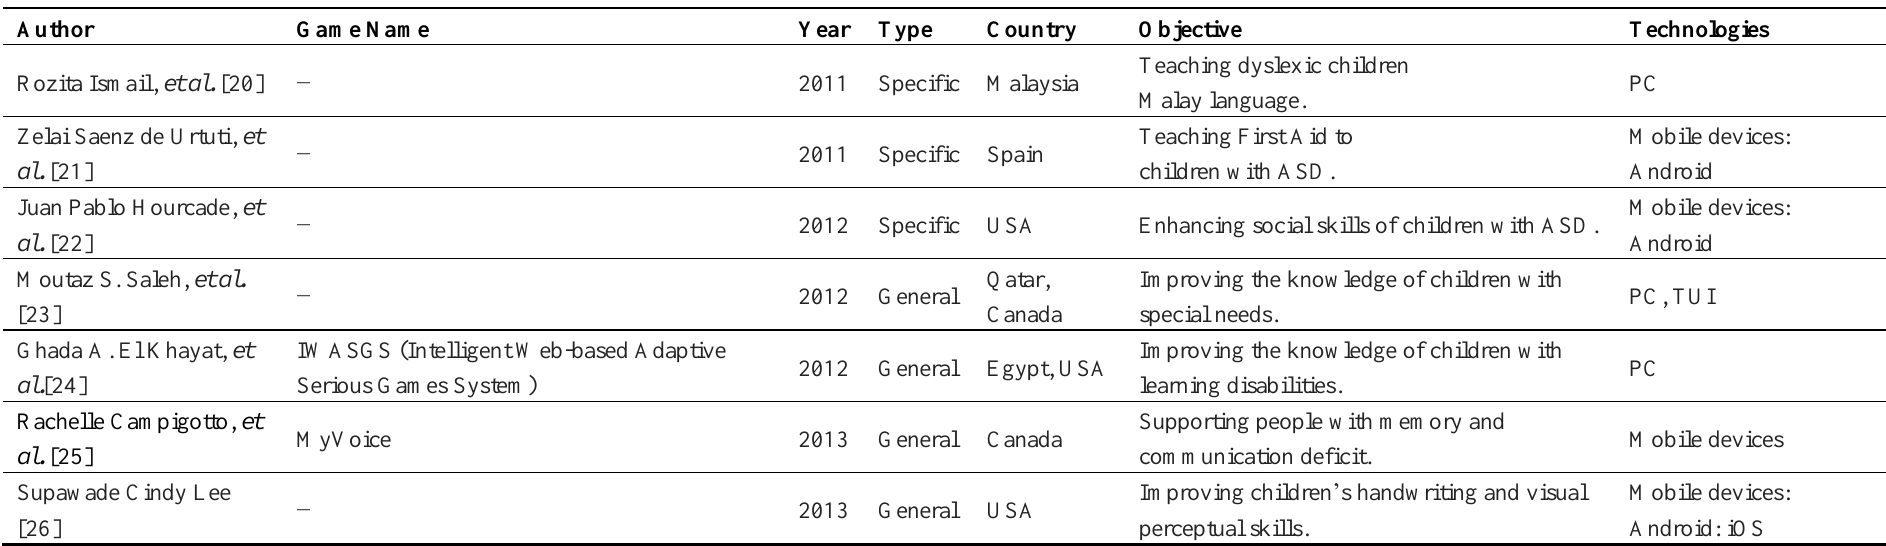
Table 1. Examples of applications geared towards children with special needs.